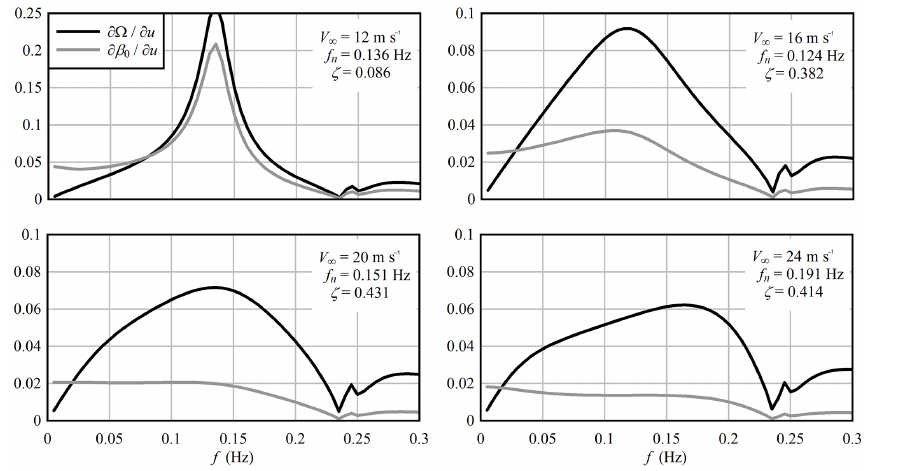
Figure 2. Closed-loop transfer functions of collective blade pitch (gray lines) and rotor speed (black lines) with respect to a uniform sinusoidal perturbation in the axial wind speed. Angular units are radians. Note the different y axis scale of the upper-left plot.